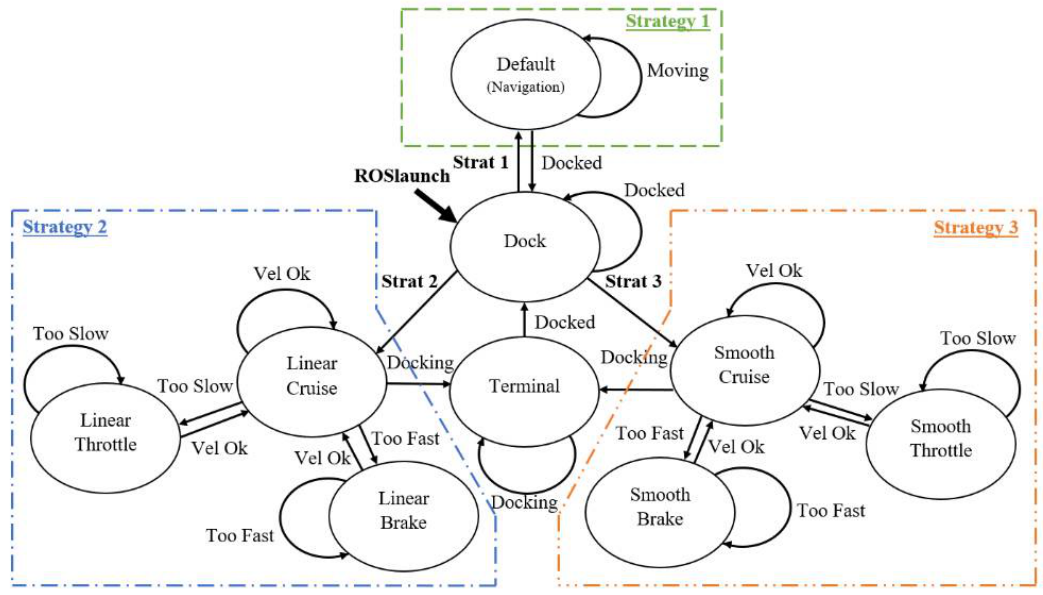
Figure 7. Motion strategy state machine—VelProSMACH_V2.